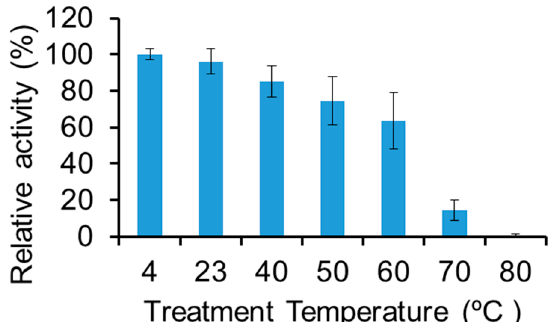
Figure 4. Thermostability of LysBC17. LysBC17 was incubated at the target temperature for 15 min, and then subjected to turbidity reduction assay to determine residual activity. Experiments run, N = 3. Relative activity of 100% assigned to the maximum value in the data set. Error bars represent the standard deviation.